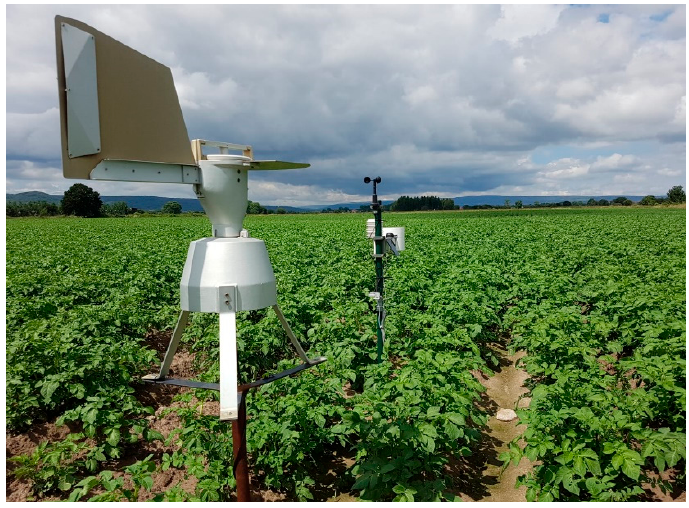
Figure 1. iMETOS ® 3.3. by Pessl Instruments weather station and Lanzoni VPSS 2000 volumetric sampler.